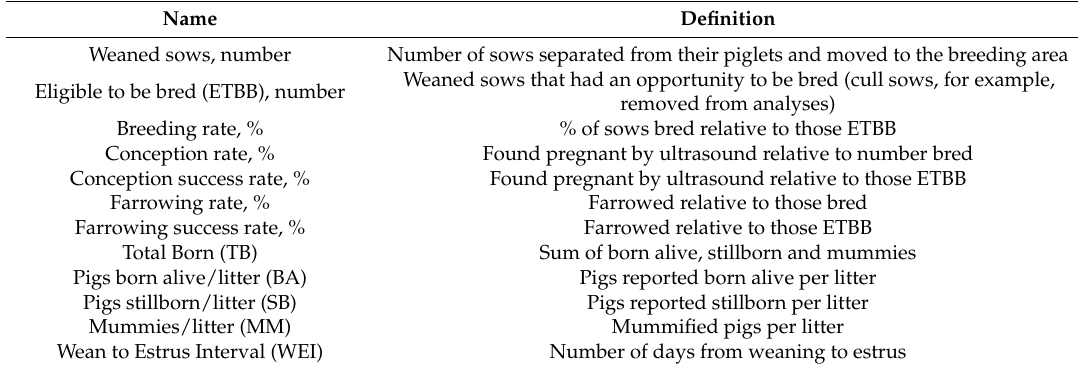
Table 1. Definitions of reproductive response